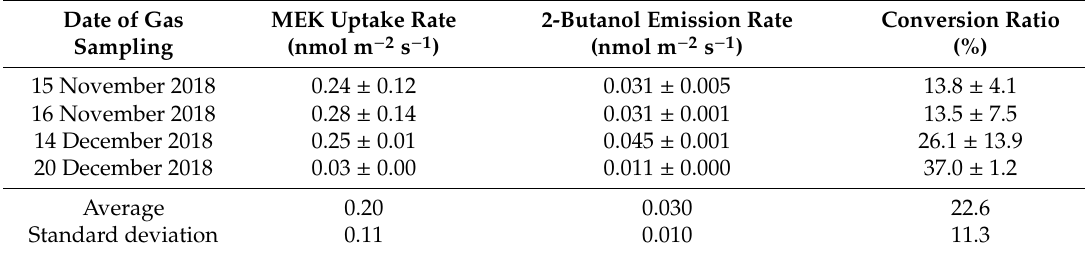
Table 2. MEK uptake rate, 2-butanol emission rate, and conversion ratio of MEK to 2-butanol of S. clevelandii .